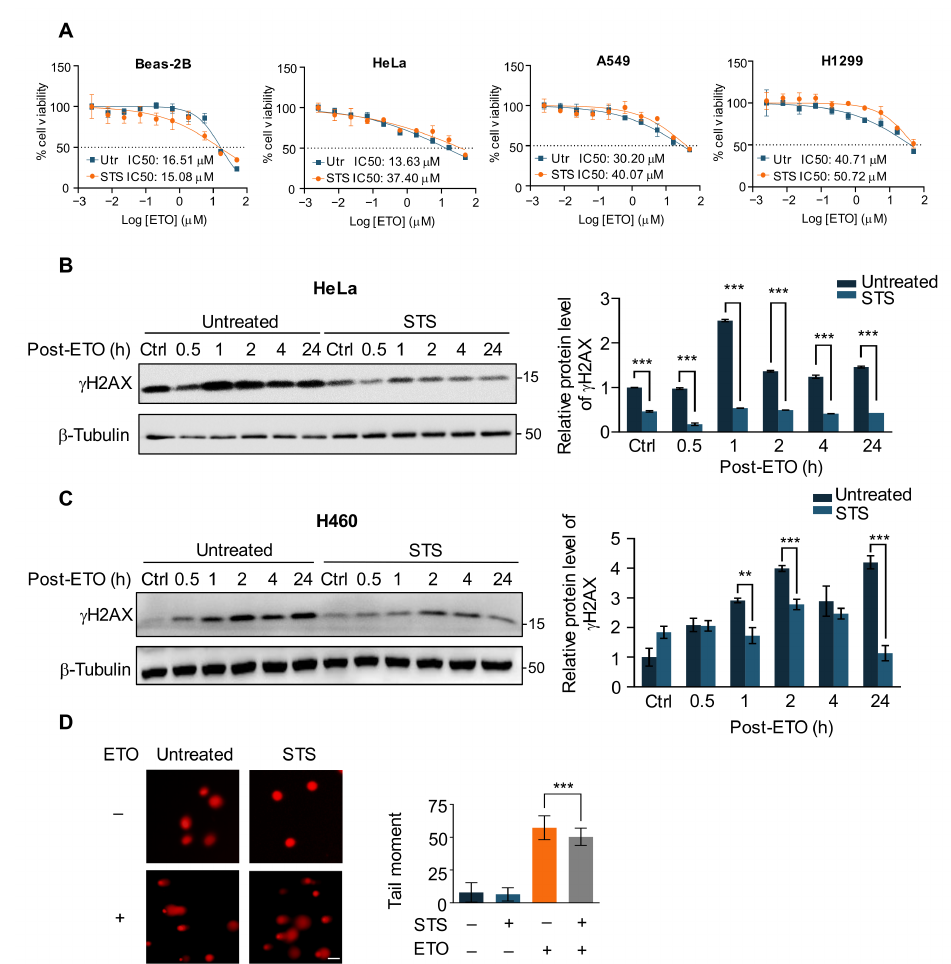
Figure 1. Short-term starvation protects cancer cells against ETO by reducing DNA damage. ( A ) Dose- response curves with IC50 values that indicate cell lines pre-starved or left untreated for 24 h were treated with the indicated concentration of ETO for 48 h. ( B ) Immunoblot ( left ) and quantification ( right ) of γ H2AX in HeLa cells pre-starved or untreated for 24 h with 20 µ M ETO treatment for 2 h following different recovery times. ( C ) Immunoblot ( left ) and quantification ( right ) of γ H2AX in H460 cells pre-starved or untreated for 24 h with 20 µ M ETO treatment for 2 h following different recovery times. ( D ) Comet assay images ( left ) showing the tail moment ( right ) of pre-starved or untreated HeLa cells with or without 20 µ M ETO treatment for 2 h. Scale bar, 100 µ m. Data is represented as mean ± SD of at least three independent experiments. p values are from student’s t -tests. ** p < 0.01; *** p <